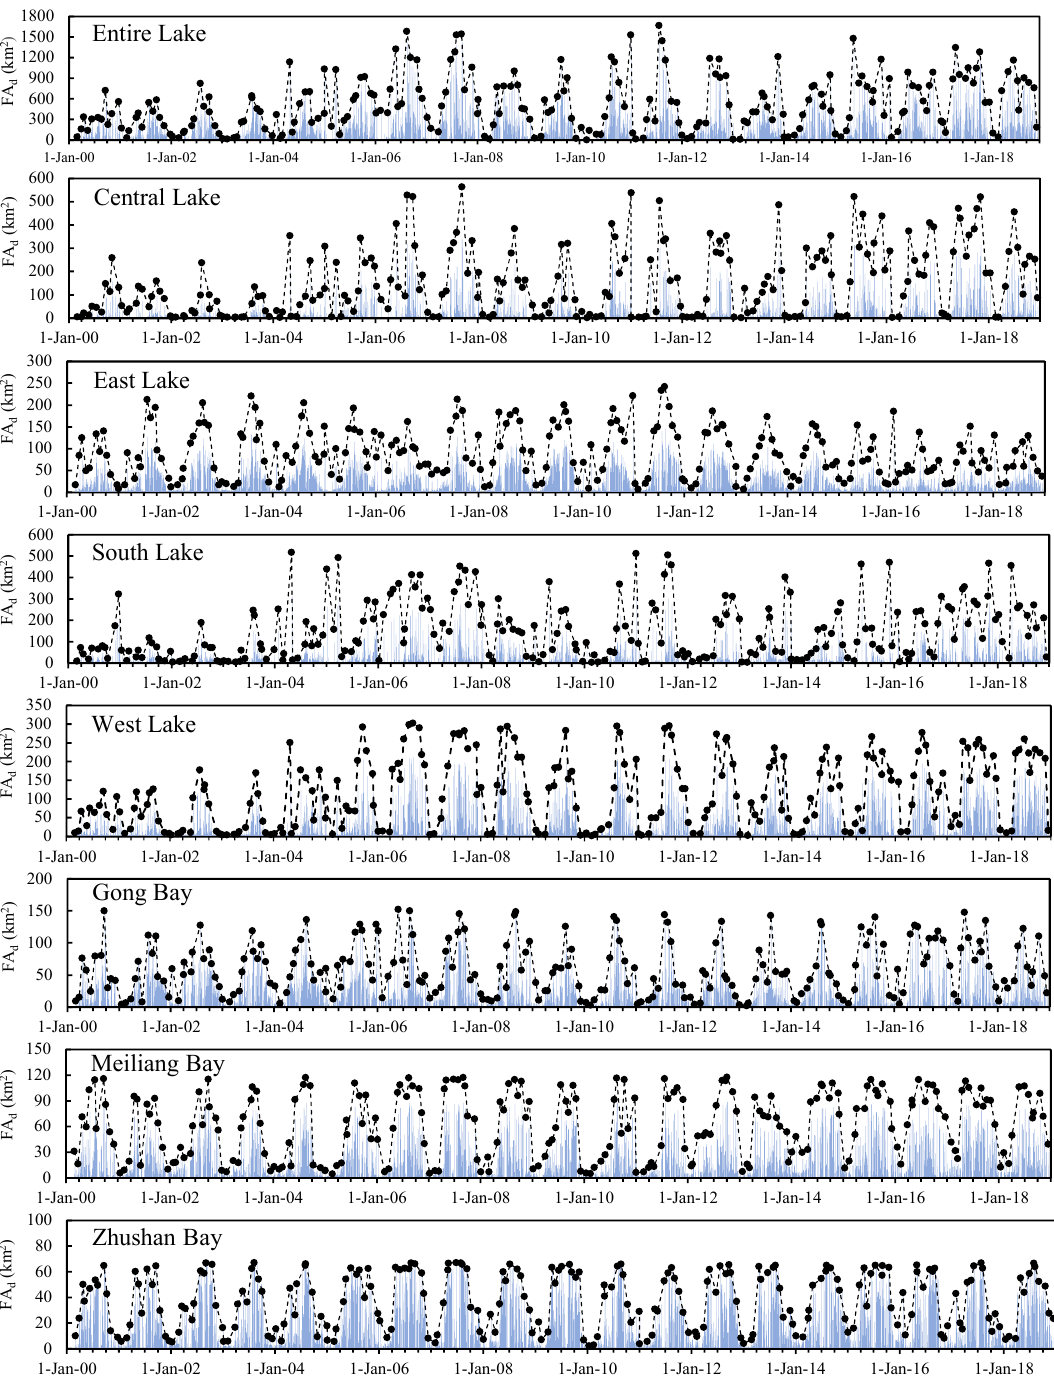
Figure 8. Daily coverage area of floating cyanobacteria (FA d ) for the entire lake (excluding East Bay) and each segment. FA d represent floating algae index (FAI) > − 0.004 coverage area. Solid circles represent the monthly maximum FA d